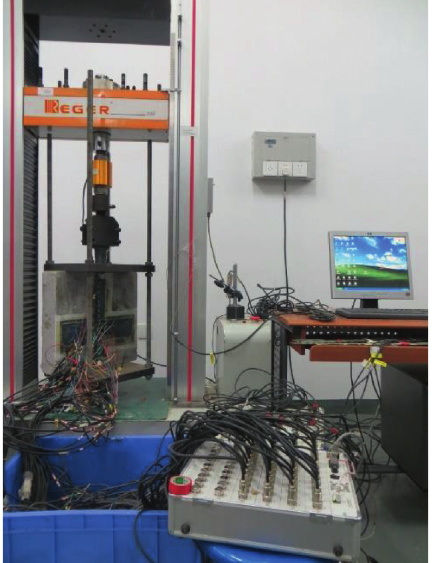
Figure 2: Test setup for single shear test.